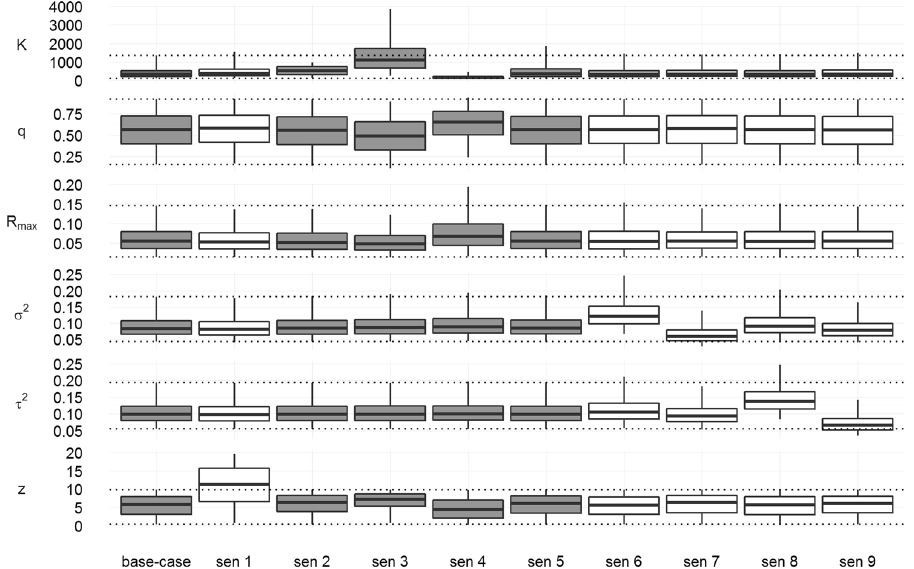
Figure 4. Sensitivity of model parameters to prior probability specifications. Median estimates (solid black lines in boxes), first and third quartiles (boxes), and their 95% C.I. (bars) are presented. For each parameter considered (detectability coefficient q , carrying capacity K (in thousands), maximum rate of increase R max , shape parameter z , process variance σ 2 and observation variance τ 2 ), two grey dotted lines indicate as references the 95% confidence intervals obtained with the base-case model. Sen 1 modified z , sen 2–5 modified K and sen 6–9 modified σ 2 and τ 2 . See Table 5 for a description of sensitivity